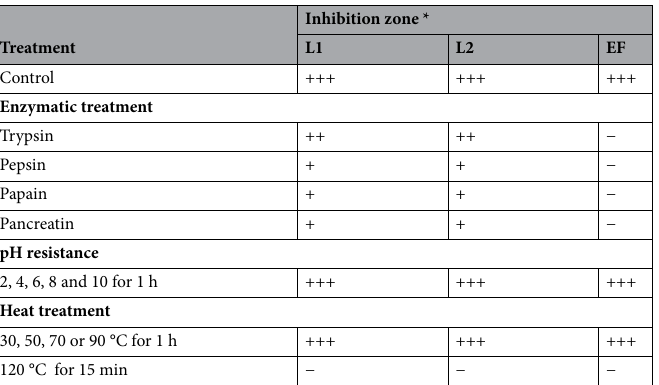
Table 4. Effect of enzymatic treatment, pH and temperature on the stability of the BLIS produced by L. lactis (L1 and L2), and E. faecium 135 (EF). *(+++) > 12 mm, (++) 10–11.99 mm, (+) 8–9.99 mm, and (–) did not show inhibition zone. The bioindicator strain used to evaluate antimicrobial activity was Listeria monocytogenes CECT 934. Control: BLIS without any treatment. The concentration of the enzymes used in the experiments was 1%